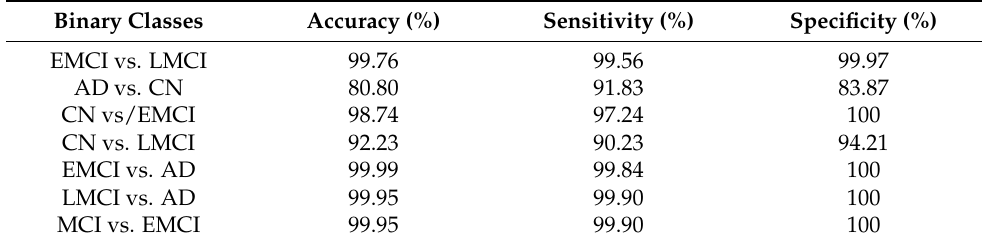
Table 7. Metrics of Evaluation on Validation Data for Model with